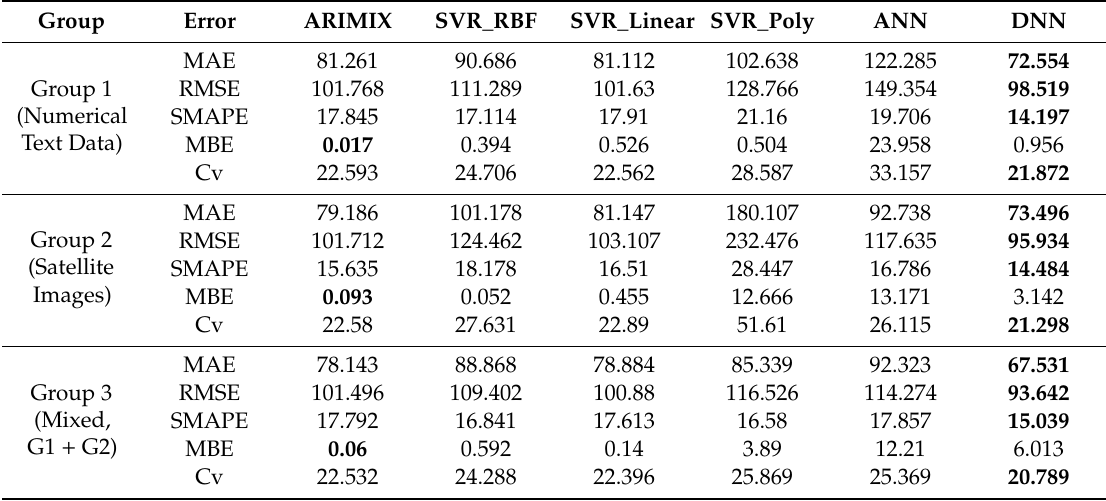
Table 10. Solar PV generation prediction result of case